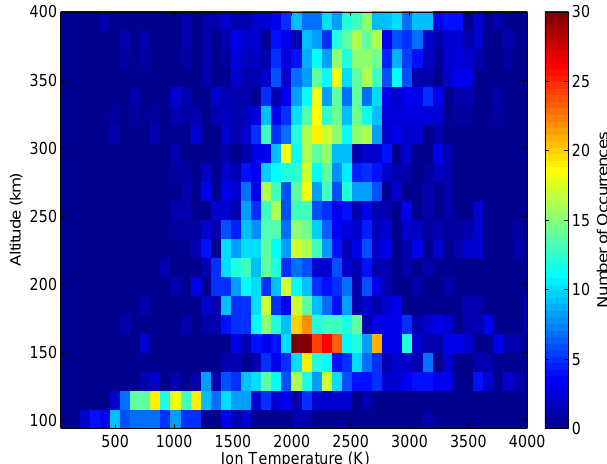
Fig. 6. A two-dimensional histogram of ion temperature vs. alti- tude. Profiles like those shown in Fig. 1 show up statistically in the